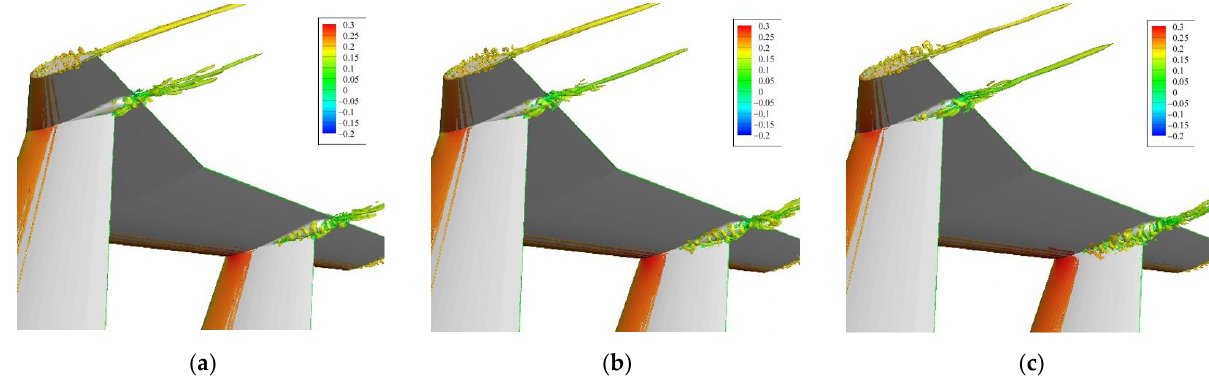
Figure 20. Ω = 0.52 isosurface, looking from the suction side of modified model: β = ( a ) 0 ◦ , ( b ) 2 ◦ ,